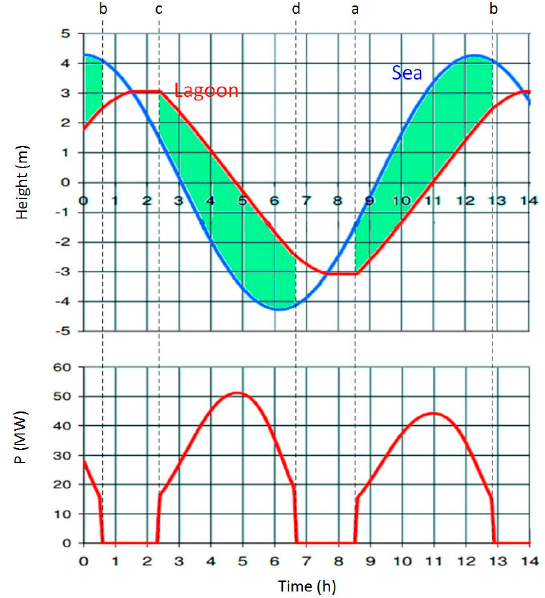
Figure 10. Sea water level, lagoon water level and energy generation for one tidal period (half tidal day), and for a 60 MW lagoon. Adapted from [44].